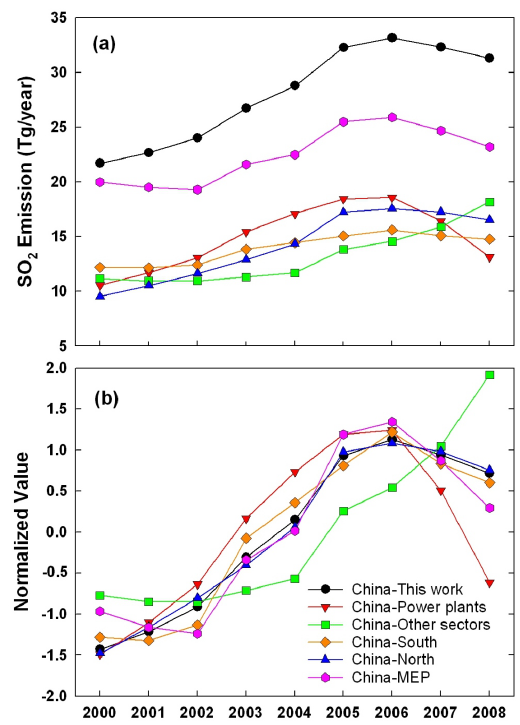
Fig. 2. Trends of SO 2 emission in China, 2000–2008. (a) SO 2 emission; (b) Normalized values of SO 2